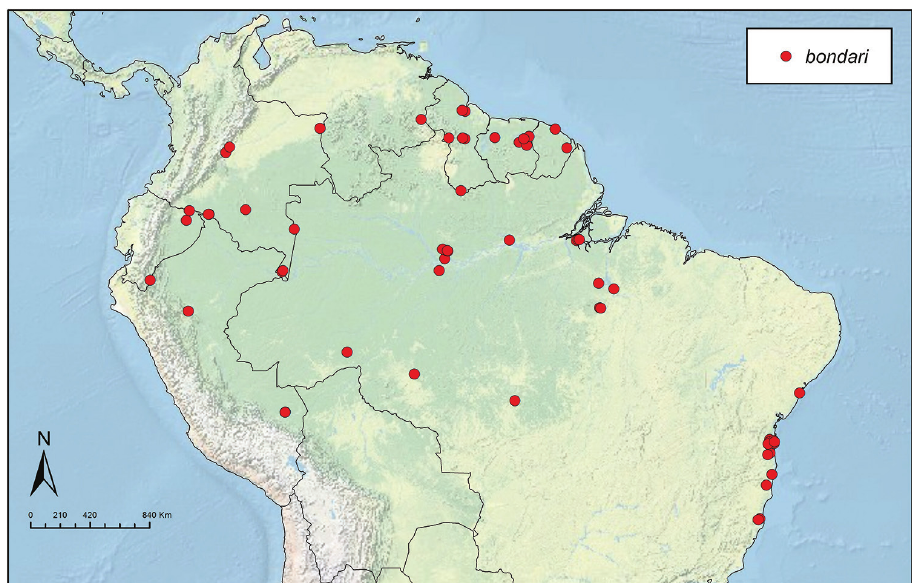
Figure 27. Distribution map of S. bondari